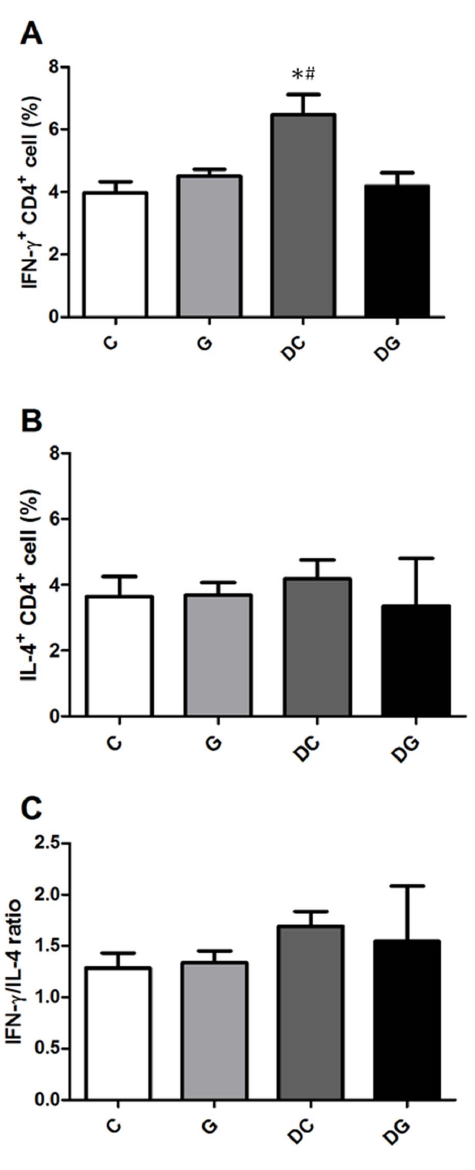
blood. Lymphocytes were gated according to their size and granularity using light scatter detectors (FSC/SSC). CD4-positive lymphocytes were considered Th cells and were gated to determine the expression of intracellular cytokines. A, B: Percentages of interferon (IFN)- c - and interleukin (IL)-4-expressing CD4 + lymphocytes. C: IFN- c /IL-4 ratio. Data are presented as the mean 6 SEM. Differences among groups were analyzed by ANOVA using the Tukey’s test. *Significantly differs from the C group. # Significantly differs from the DG group ( p , 0.05).